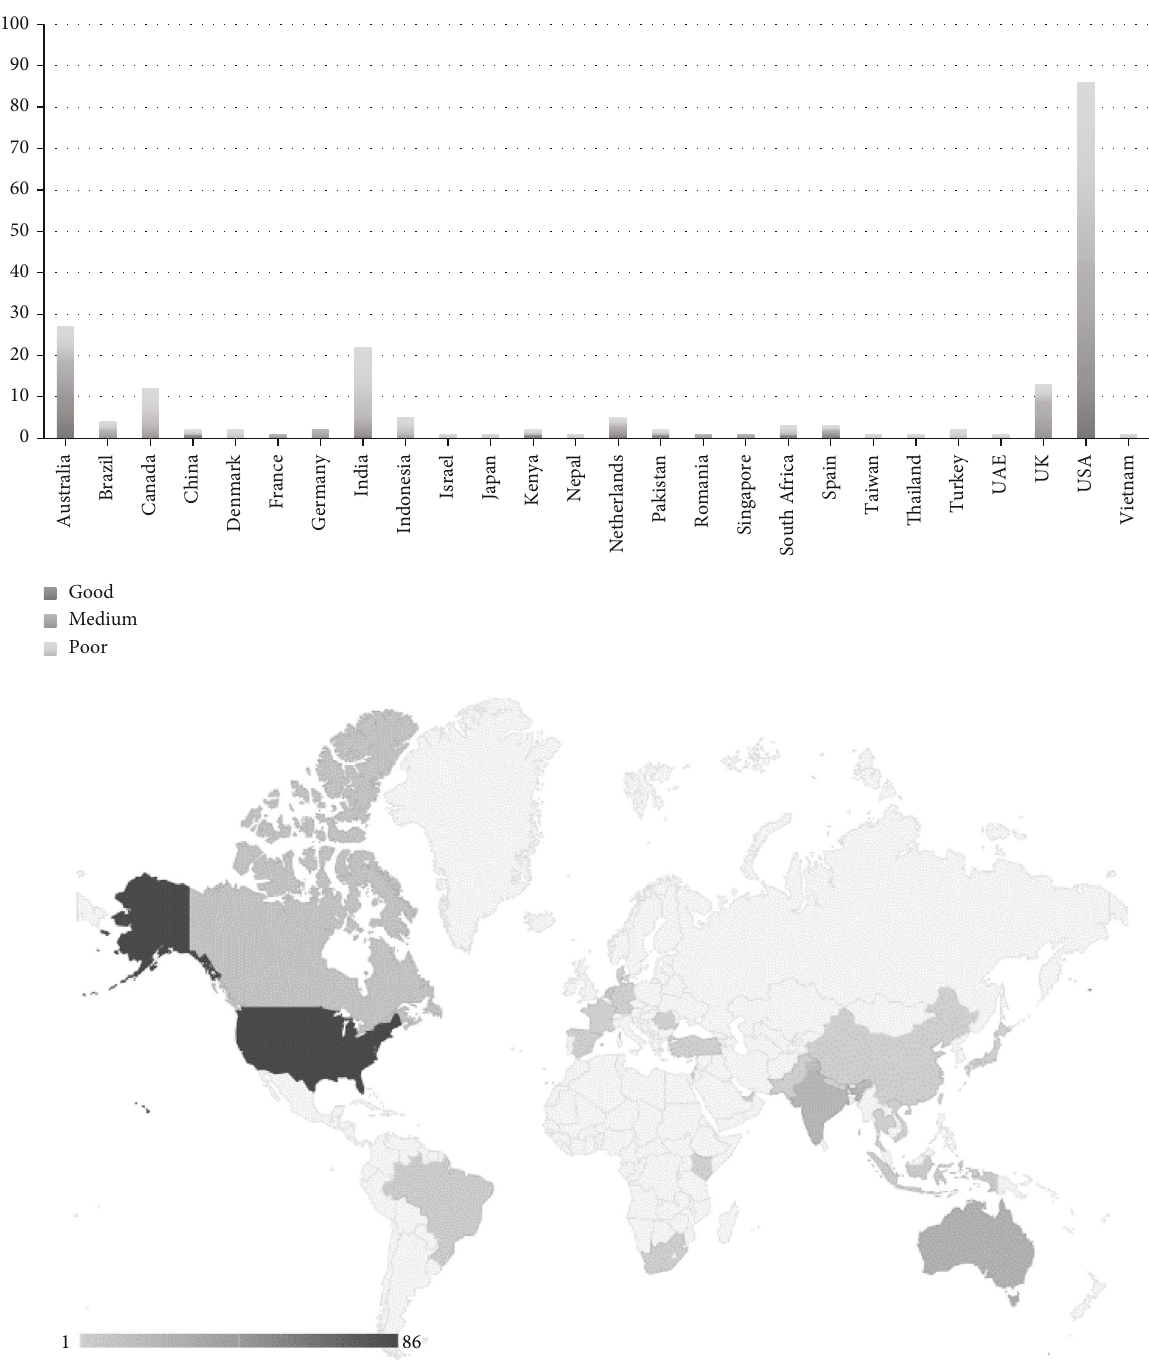
Figure 4: Country-wise distribution of categorized hydroponic technology content on